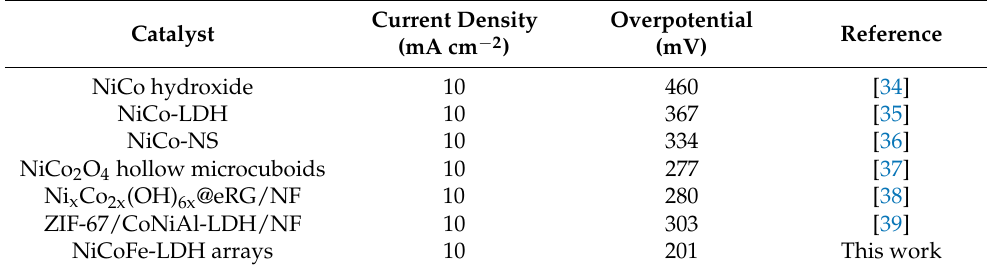
Table 4. Comparison of OER performance of this work with other reported NiCo-based electrocatalysts.